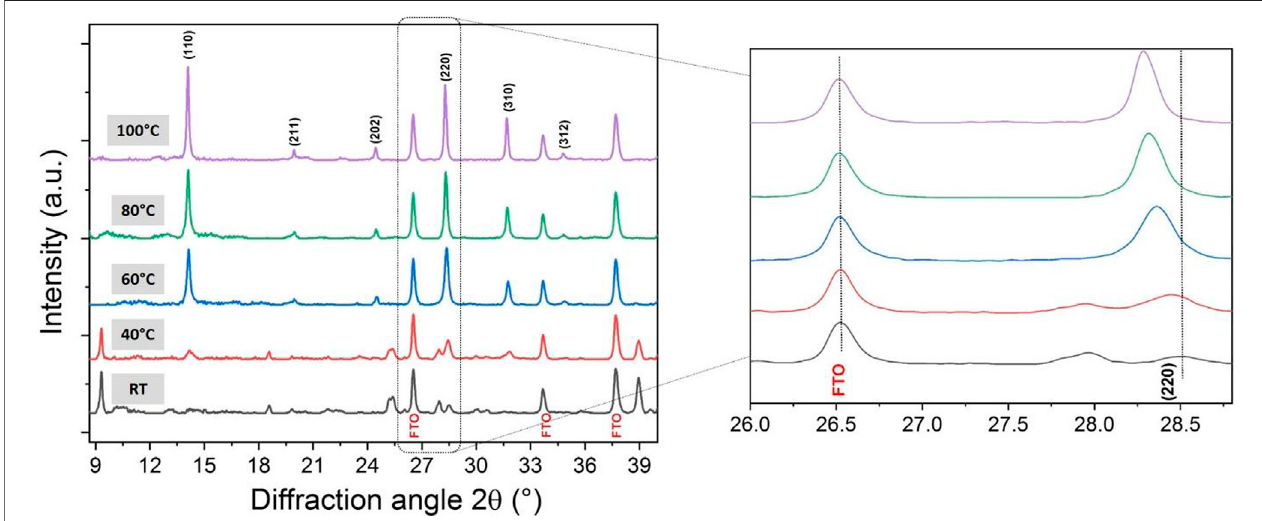
FIGURE 2 | (A) In situ X-ray diffraction study as a function of temperature for a spin-coated fi lm of 1:1 ratio of MAI and PbI 2 . The inset shows the (220) diffraction peak shift of MAPbI 3 .